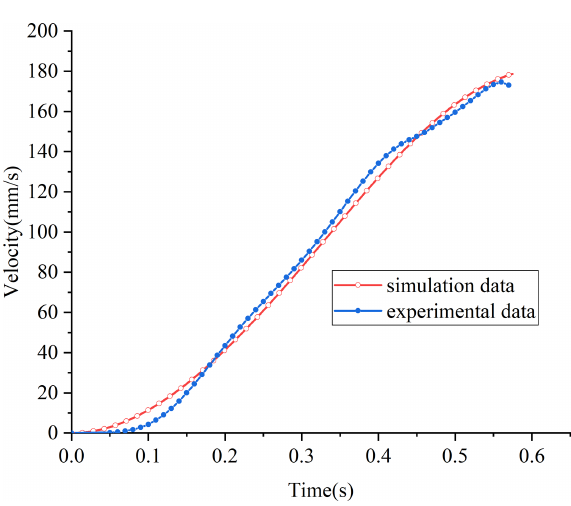
Figure 17. Comparison curve of displacement simulation value and experimental value of the macro–micro composite actuator.